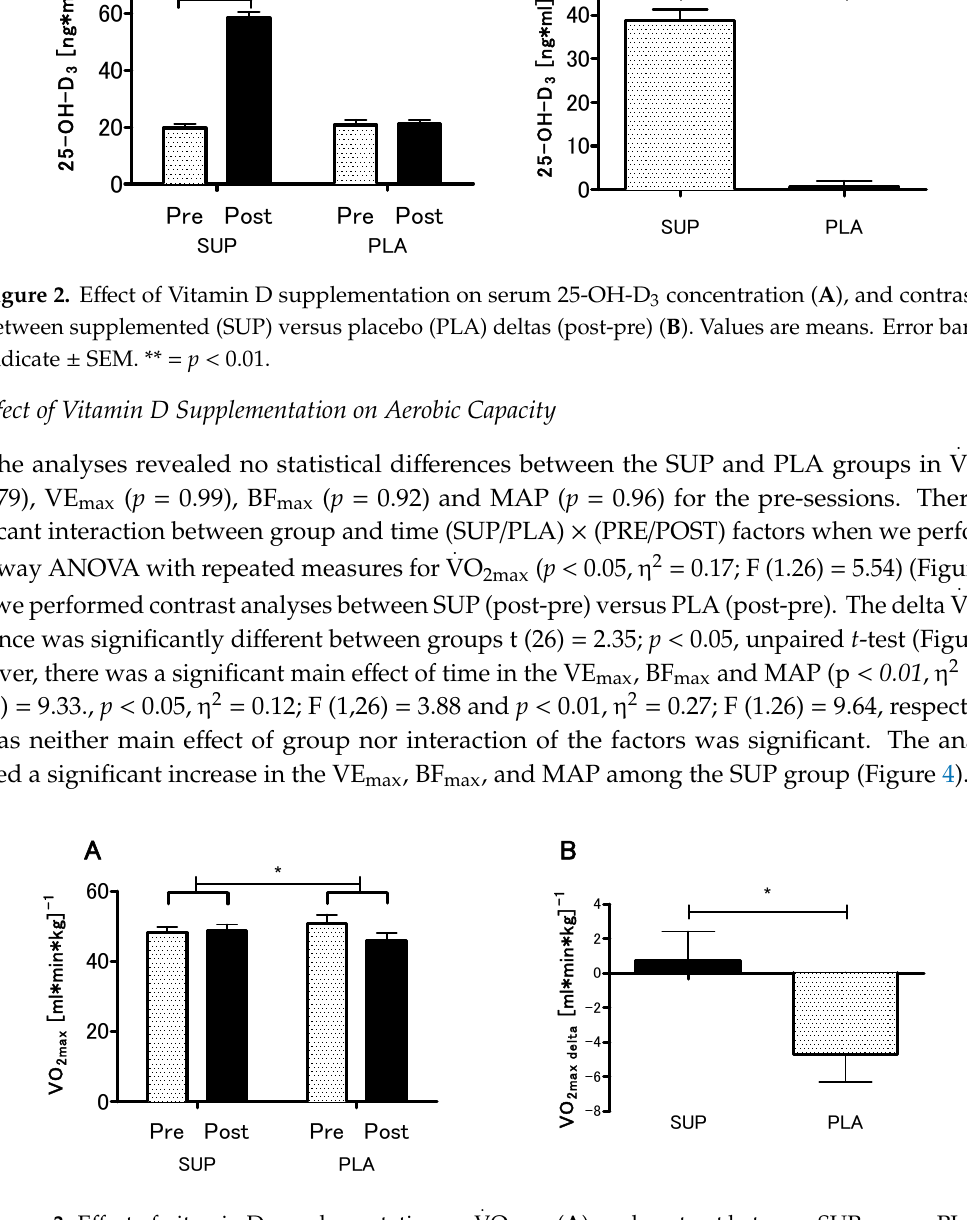
Figure 4. Effect of vitamin D supplementation on maximal minute ventilation VE max ( A ) maximal breath frequency BF max ( B ) and maximal aerobic power MAP ( C ) recorded during the V ． O 2max test. Values are means. Error bars indicate ± SEM (standard error of mean). * = p < 0.05. 3.4. Effect of Vitamin D Supplementation on Anaerobic Capacity Analyzing the effect of Vitamin D supplementation on anaerobic capacity parameters, a significant main effect of time in the MAnP and Work ( p < 0.01, η 2 = 0.51; F (1,26) = 28.10 and p < 0.01, η 2 = 0.52; F (1,26) = 28.54, respectively) were found, whereas neither main effect of group nor interaction of the factors was significant (Figure 5A,B). Detailed results of the physical capacity tests in the present study are listed in Supplementary Table S1.